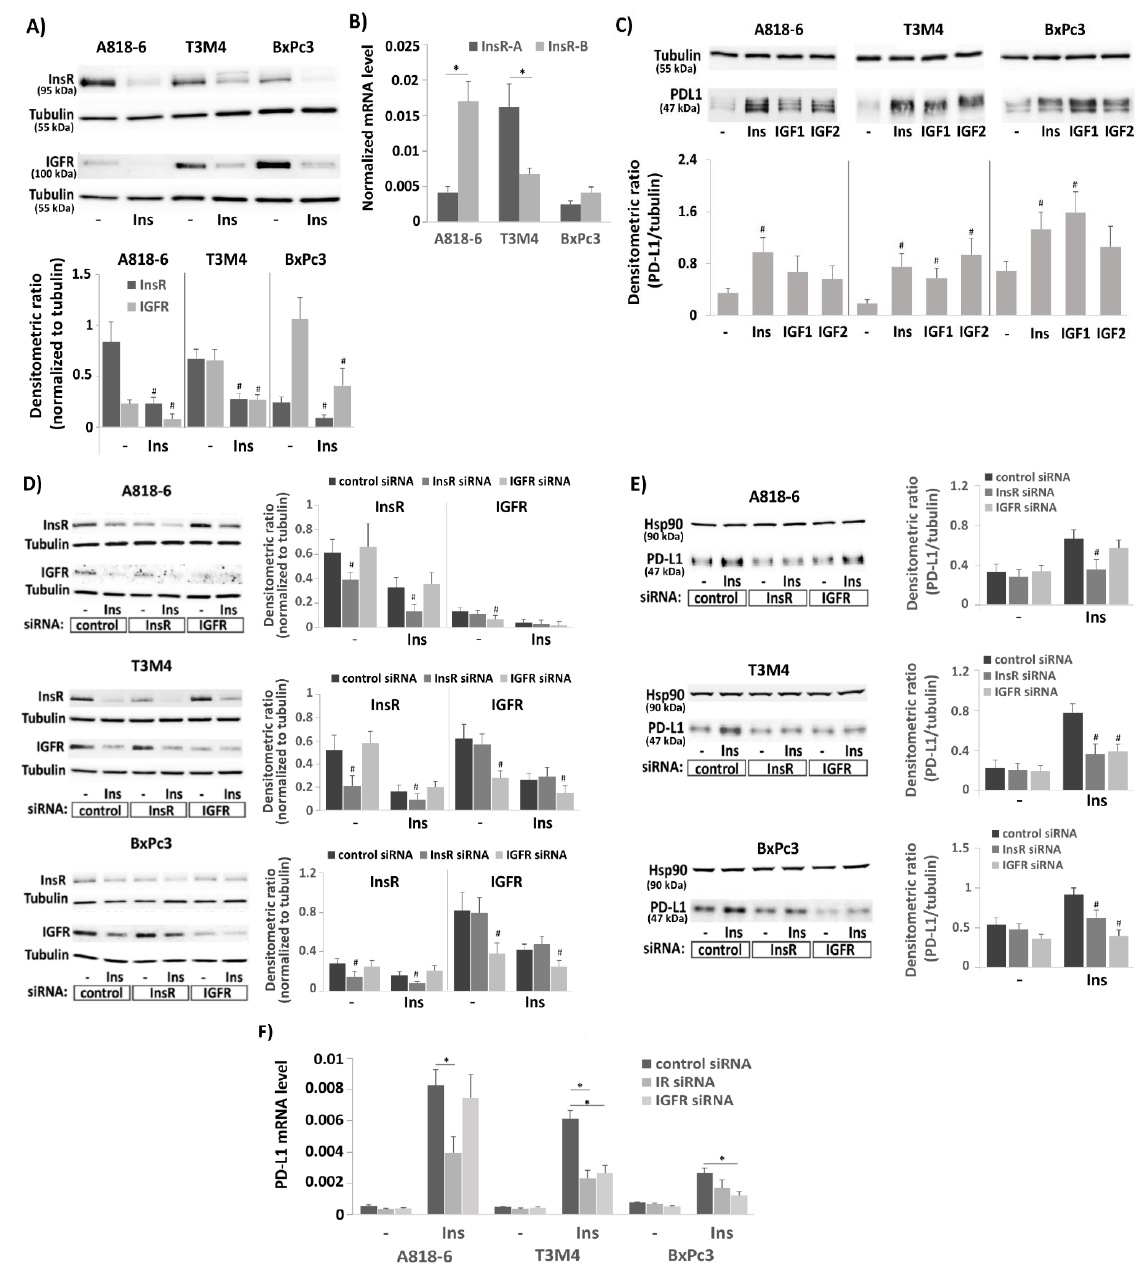
Figure 2. Involvement of insulin receptors (InsR) and IGF receptors (IGFR) in the insulin-induced PD-L1 expression in PDAC cell lines. ( A – C ) Serum-starved A818-6, T3M4, and BxPc3 cells were either left untreated ( B ) or were treated ( A